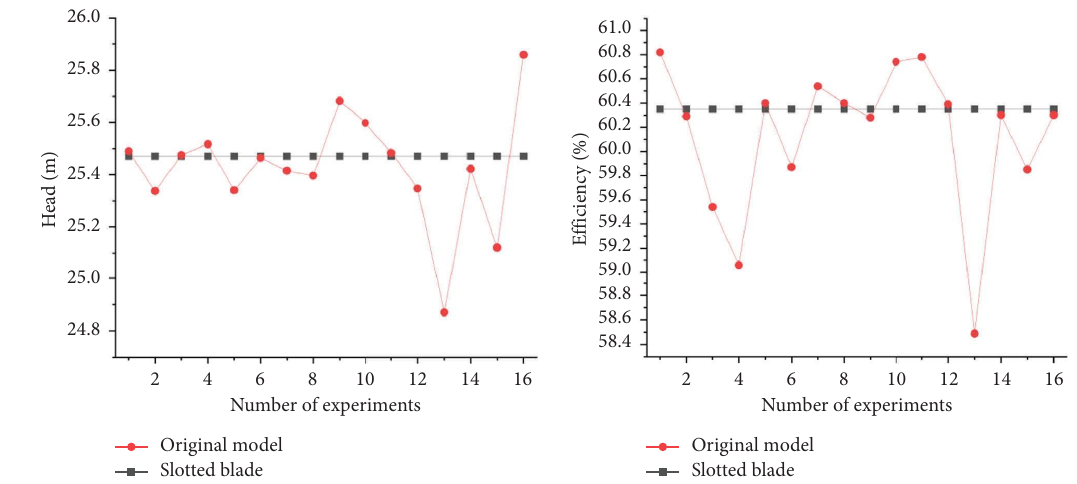
Figure 10: Orthogonal test results fgure.